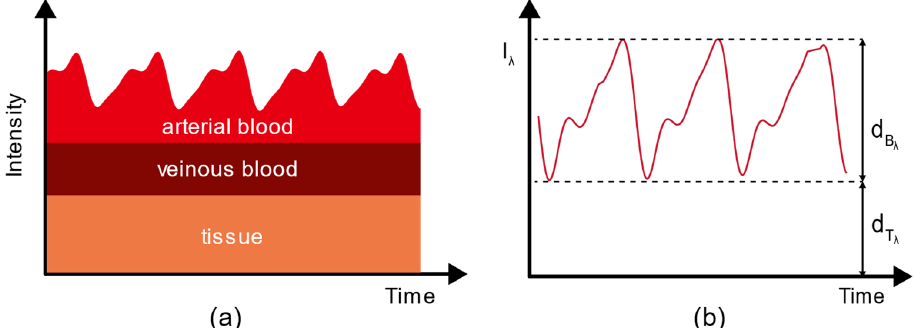
d represents rep- λ